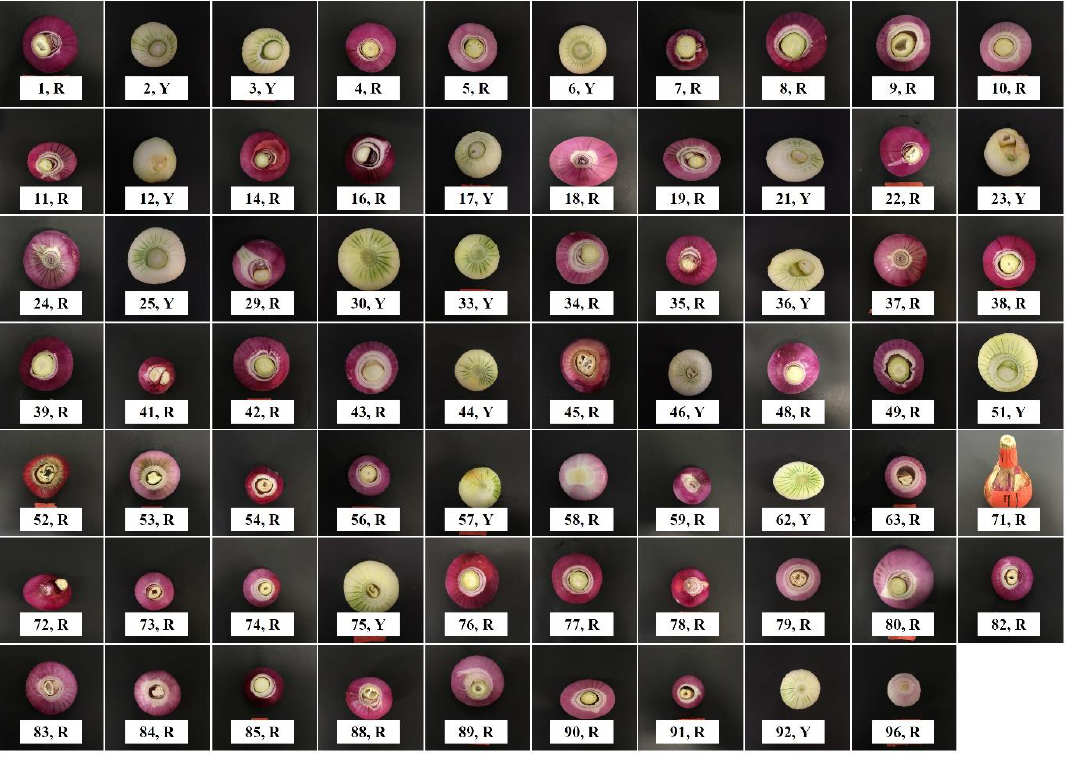
Figure 3. Bulb colors of 69 F 2 individuals derived from a cross between Allium cepa ‘SP3B’ and ‘H6′ . Numbers, No. of F 2 individual; R, red color; Y, yellow color.